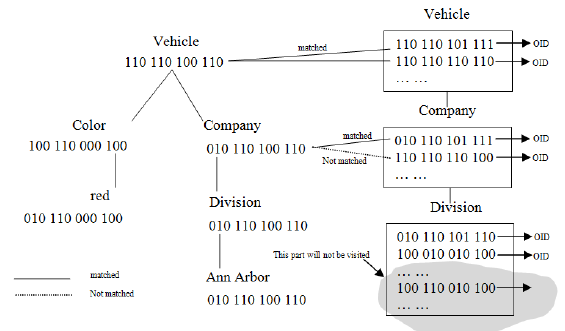
Figure 5 . Illustration of query evaluation